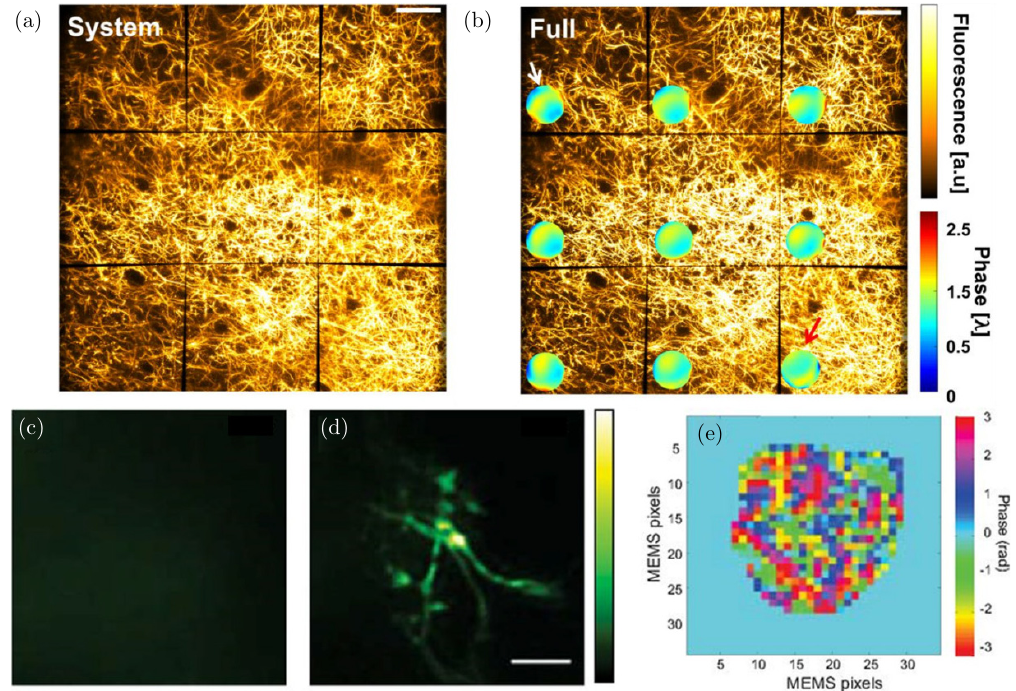
Fig. 3. Imaging through aberrating and highly scattering tissue. (a) Maximum intensity projection (MIP) of 10 (cid:1) m thick volume of brain tissue at 75 (cid:1) m depth in live tissue obtained using conventional multiphoton microscopy, (b) After simultaneous-independent aberration correction for 9 di®erent areas of the FOV. Inset shows the aberration maps for the respective FOV. 58 Scale bars 50 (cid:1) m , (c) MIP of 20 (cid:1) m thick volume of brain tissue through the intact skull via conventional multiphoton microscopy. No structure can be seen due to multiple scattering, (d) After sensorless wavefront shaping. Fine structures of microglia are recovered and (e) According wavefront correction map. Each pixel of the wavefront modulator requires independent modulation due to multiple scattering induced randomness. 85 Figures (a) – (b) reprinted with permission from Ref. 58 and (c) – (e) from Ref.